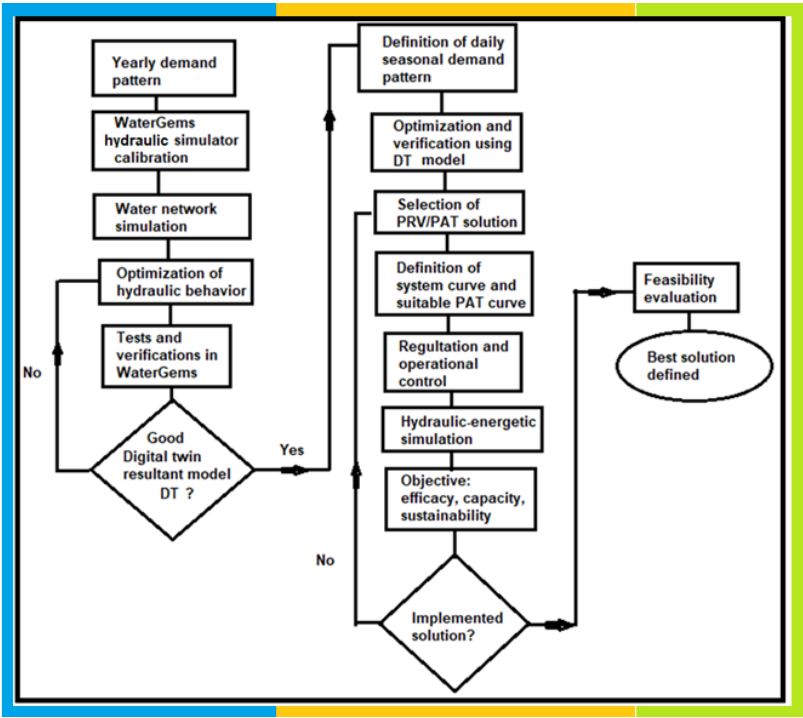
Figure 3. Flow-chart of the proposed integrated efficiency management methodology.